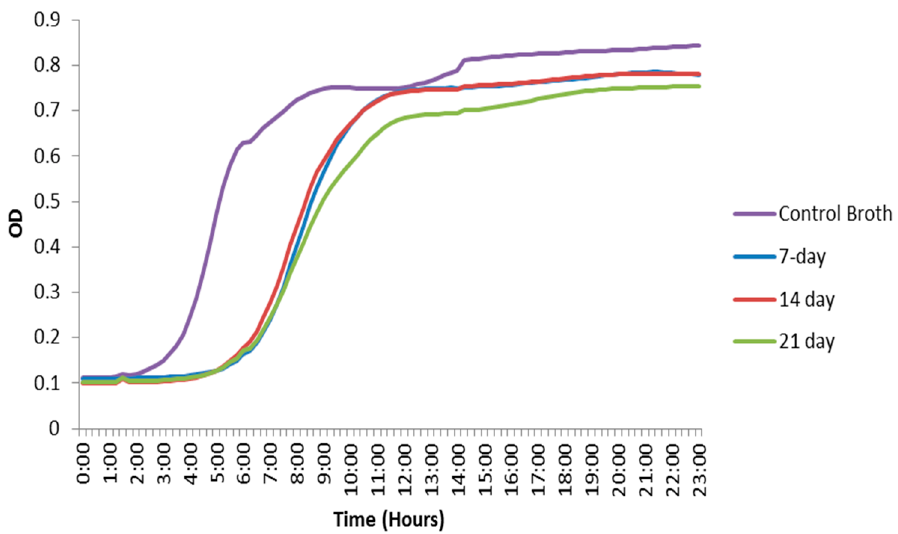
Figure 5. Optical density curves of E. faecalis . Broth that had contained CHX-encapsulated nanoparticles show a growth delay compared to the positive control broth that had not contained any nanoparticles.